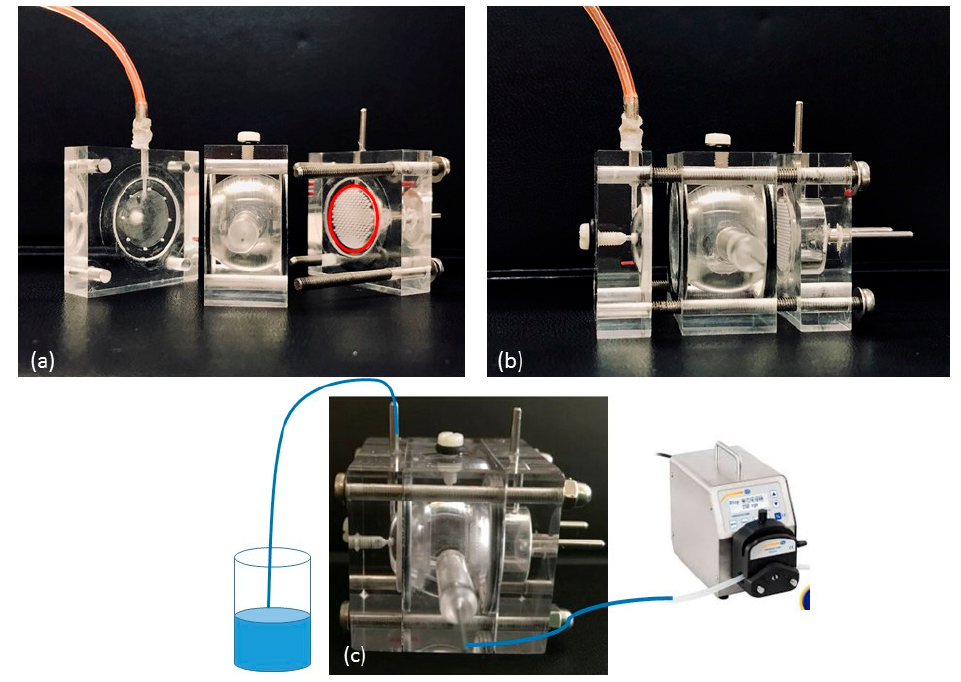
Figure 1. Ocular flow cell: ( a ) the separated three-compartments and the semipermeable disk, possible support for retinal cells (red circled); ( b ) the assembled flow cell with screw-secured compartments; ( c ) the cell connected with the dispensing peristaltic pump.